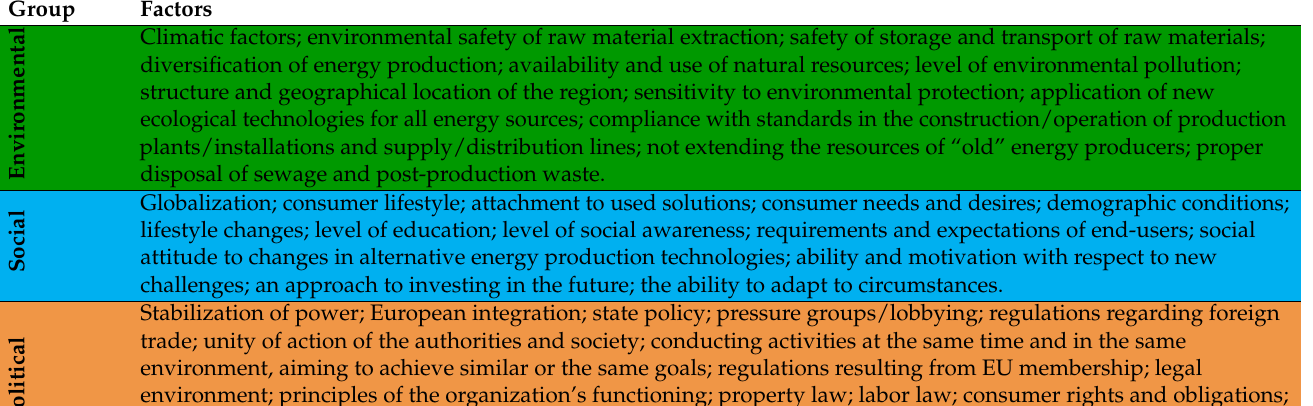
Table 5. Key success factors of the energy market in the context of ensuring energy security (ETPSE method).